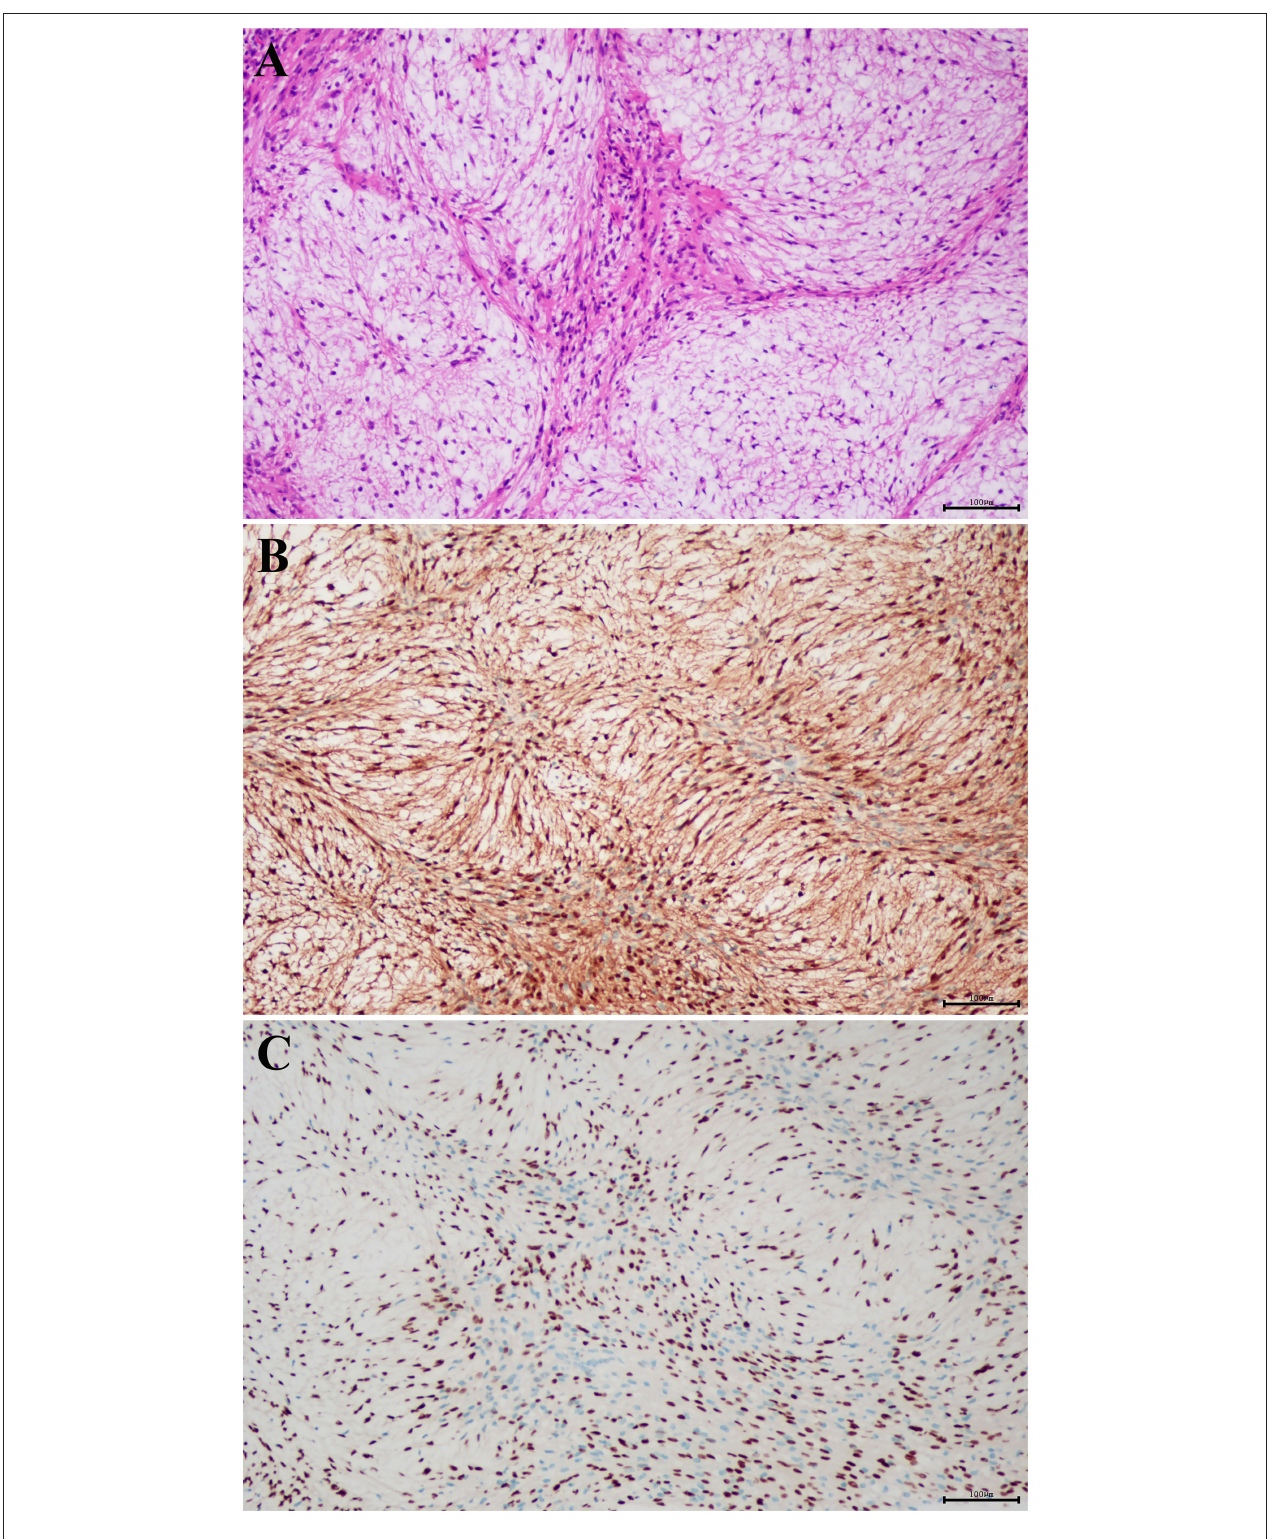
FIGURE 2 | Histopathological examination showed that the lesion was grayish red, well-circumscribed, with average blood supply, soft in quality, and located in the intraspinal subdural region (A) (hematoxylin and eosin staining; magnification, × 100). The tumor cells were positive for (B) S-100 and (C) SOX10 (magnification, ×